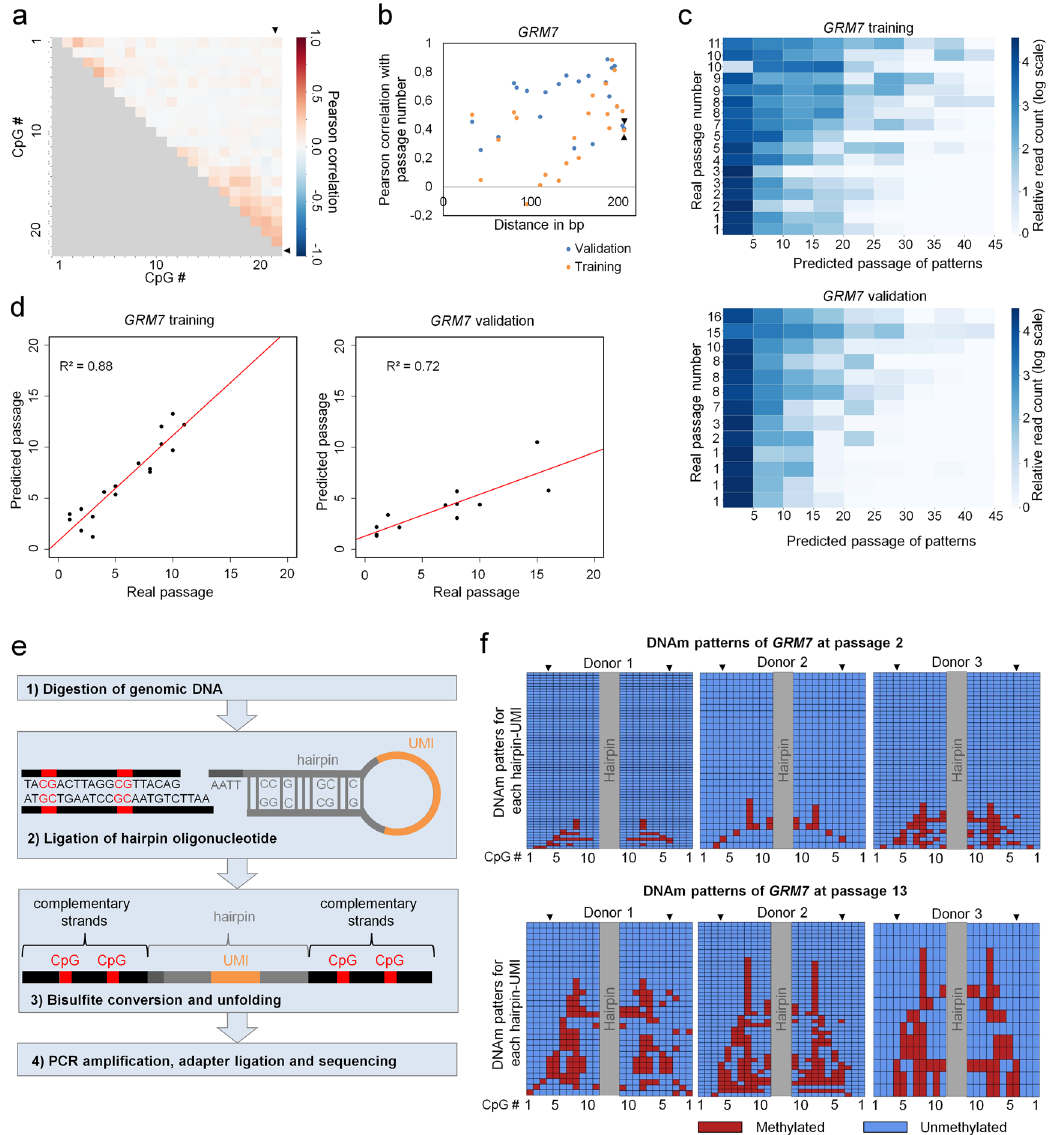
Fig. 4 DNA methylation of neighboring CpG sites in the amplicon of GRM7 . a Pearson correlation of DNAm levels at neighboring CpG sites of the BBA- Seq amplicon of GRM7 . The CpG site included in the Epigenetic-Culture-Expansion-Signature is CpG #22, depicted by black arrow heads. b Pearson correlation with passage number of neighboring CpGs in GRM7 . The CpG site included in the Epigenetic-Culture-Expansion-Signature is the CpG at 207bp, depicted by black arrow heads. Correlations are depicted for a training set (the two RGB labeled donors depicted in Fig. 3a and Supplemental Fig. 3a) and a validation set of our previous study 8 . c Heatmaps of single read predictions for the amplicon of GRM7 show a high heterogeneity of predictions within each of the samples of the training and validation set. d The mean of the single read predictions correlated with real passage numbers. e Schematic presentation of DNAm analysis on complementary DNA strands using hairpin ligation and BBA-Seq (UMI = unique molecular identi fi er). f DNAm patterns of eleven neighboring CpGs in GRM7 are depicted on complementary strands (MSC of three different donors in early and late passages). The CpG site included in the Epigenetic-Culture-Expansion-Signature is CpG #4, depicted by black arrow heads on both strands. Each row represents patterns for an UMI in the hairpin (Supplemental Data